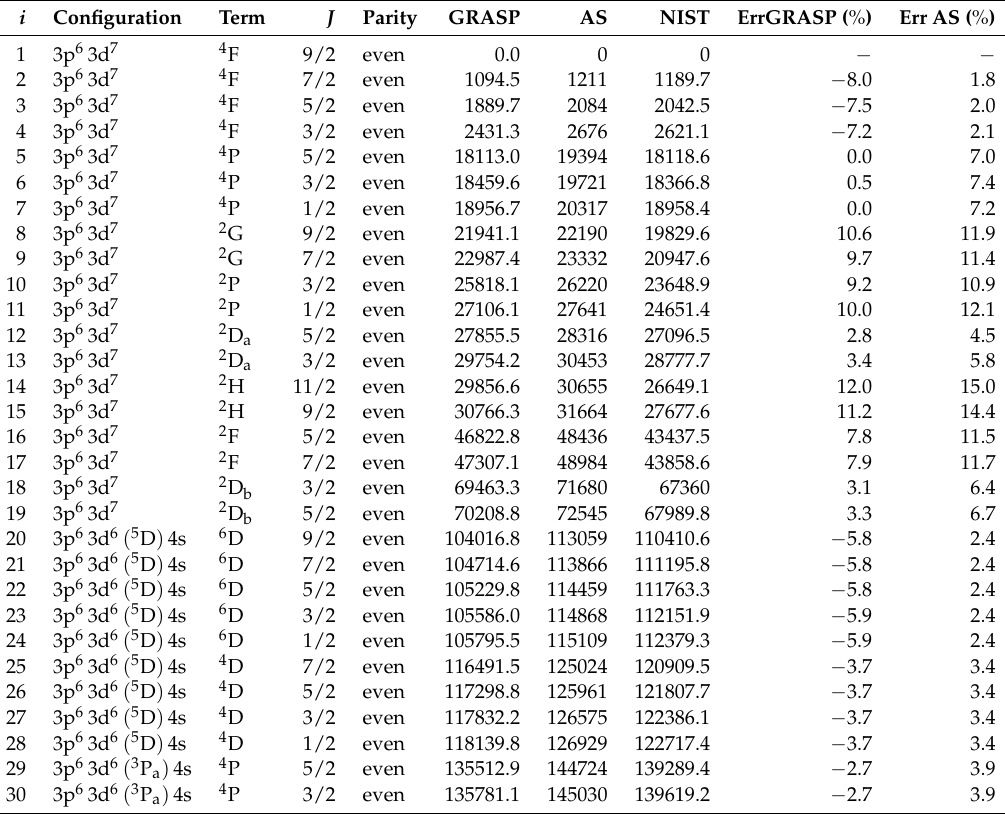
Table 1. Excitation energies of the first 30 target levels of Ni 3 + included in the present calculations. All energies in cm − 1